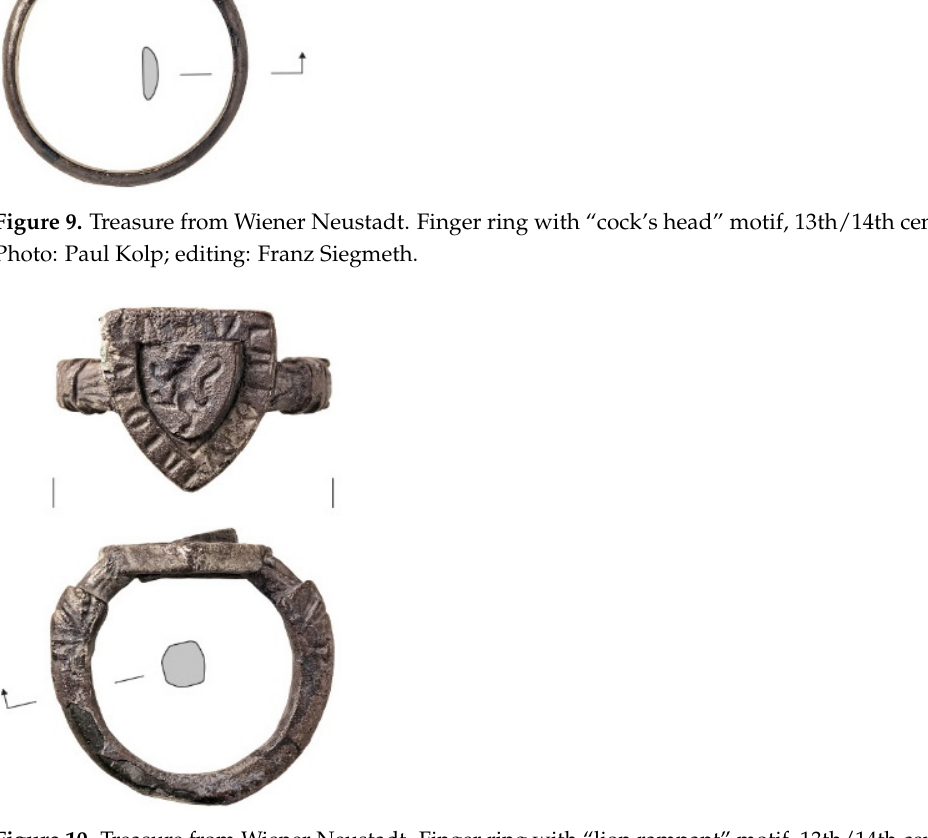
Figure 10. Treasure from Wiener Neustadt. Finger ring with “lion rampant” motif, 13th/14th century. Photo: Paul Kolp; editing: Franz Siegmeth.